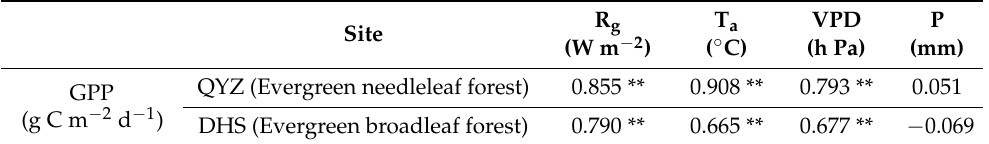
Table 1. Correlations between site-level GPP observations and the environmental factors including solar radiation (R g ), air temperature (T a ), vapour pressure deficit (VPD), and precipitation (P) at the two subtropical forest flux sites,